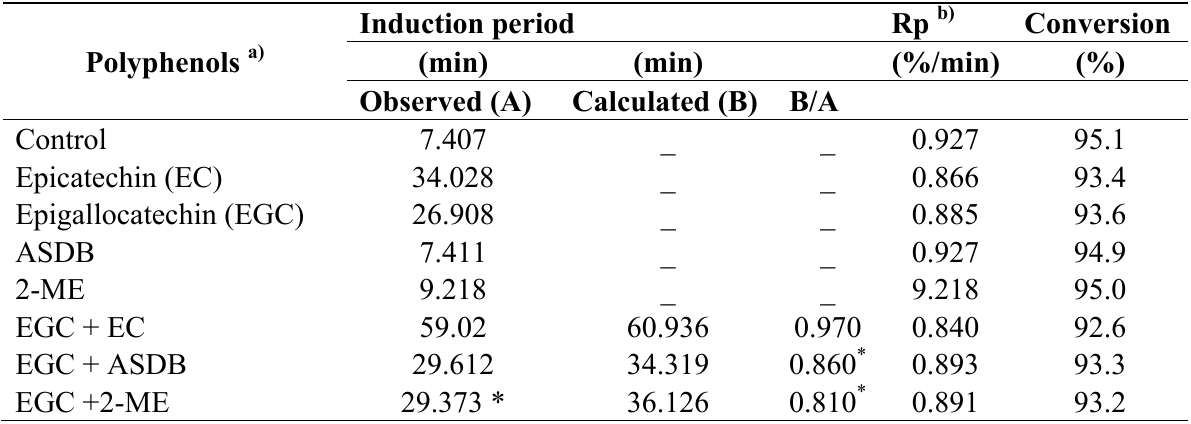
Table 3. The radical-scavenging activity for EC, EGC and the EGC:EC, ASDB or 2-mercaptoethanol (2-ME)